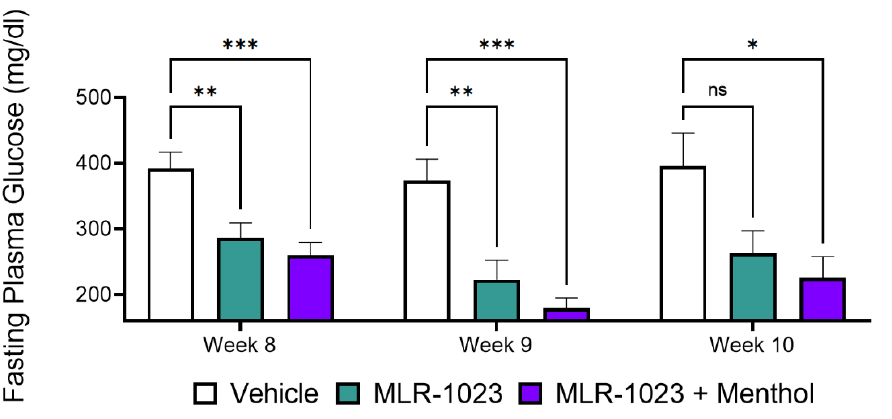
Figure 8. Effect of 100 mg/kg of MLR-1023 alone and in combination with 100 mg/kg of menthol on fasting blood glucose in db/db mice. The mice were treated with MLR-1023, the vehicle, or MLR-1023 + menthol once daily for eight weeks. Mice were followed for two weeks after treatment ended. Lean mice (BKS Cg) were similarly treated with the vehicle. Fasting blood glucose was measured weekly. N = 18 per group for eight weeks and N = 8 for weeks 9 and 10. Values are mean ± SEM. * p < 0.05, ** p < 0.01, and *** p < 0.001. ns = non-significant.